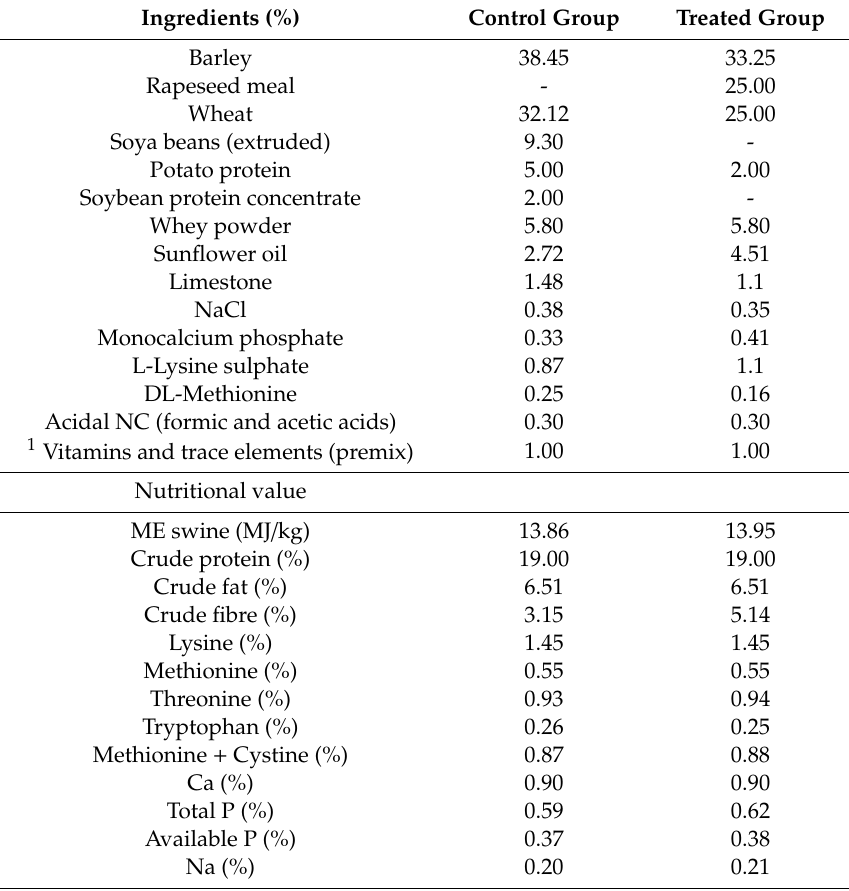
Table 1. Diet composition (dry matter 87